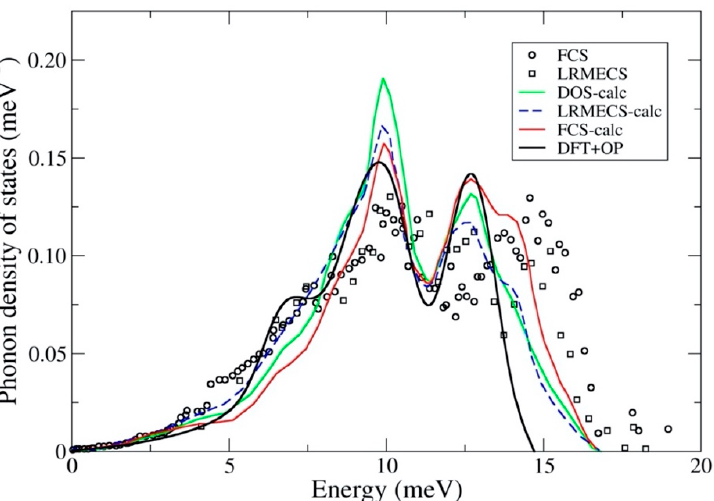
Figure 1. Measured (open squares and circles) [55] and force-constant models fitted to experiments (colored full or dashed lines) [56], and present DFT+OP (black line) phonon density of states for α uranium at 300 K. The DFT+OP result was smoothened by a Gaussian function with a 0.2 eV width.